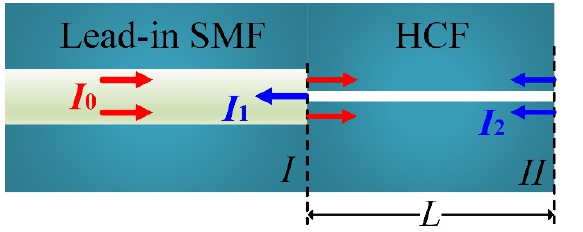
Figure 1. Schematic illustration of the proposed FPI sensor. FPI: Fabry-Perot interferometer, SMF: single-mode fiber, I 1 / I 2 : intensity ratio, I 0 : the intensity of the incident light, HCF: hollow-core fiber L : length of HCF, interface I: the SMF end facet, interface II: the HCF end facet.